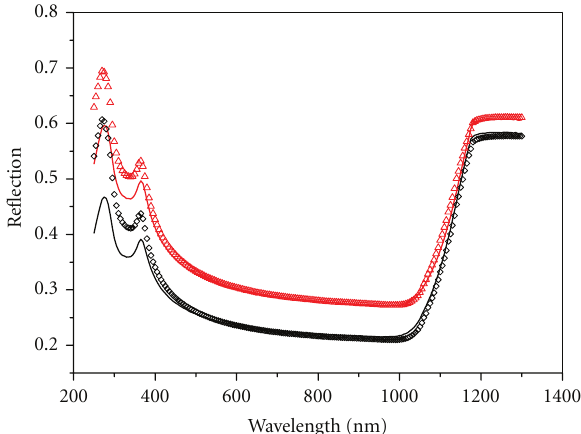
Figure 10: Simulated and measured WAR values for short- wavelength region (550nm to 600 nm) and long-wavelength region (1150nm to1200nm) graphed as a function of h / D . The black solid line and ( (cid:3) ) values represent the simulated and measured values for the short wavelength region and the red solid line and (red triangle) symbols represent the simulated and measured values for the long- wavelength